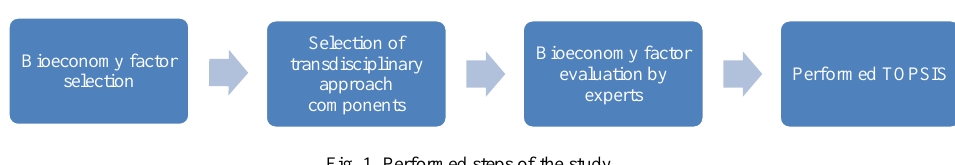
Fig. 1. Performed steps of the